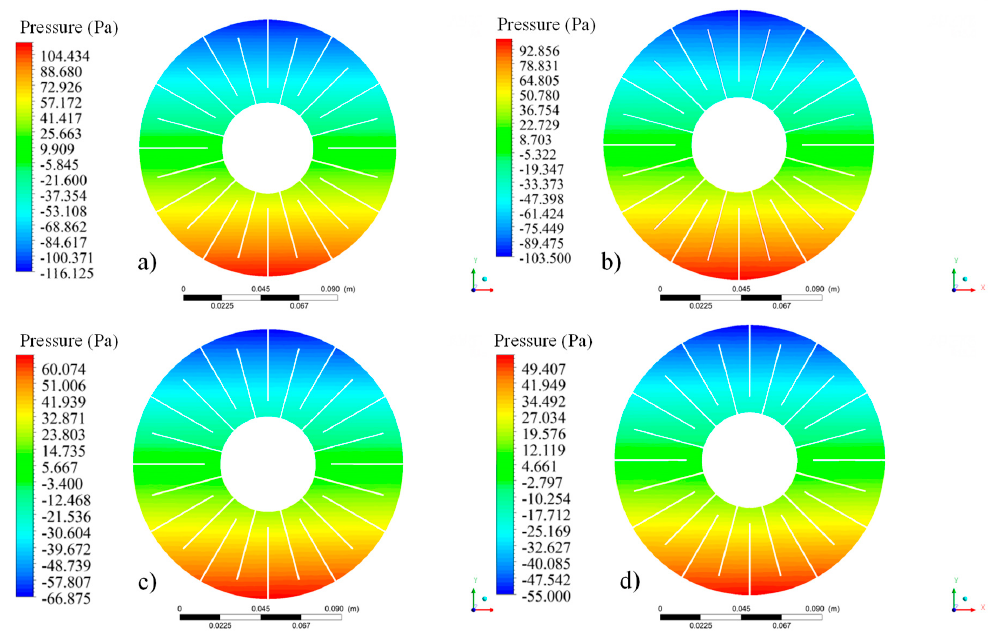
Figure 18. Pressure fields in the PCM domain for ( a ) 90% (t = 4942 s), ( b ) 80% (t = 5272 s), ( c ) 50% (t = 6522 s) and ( d ) 40% (t = 7112 s) of its volume in a liquid state. Energies 2023 , 16 , x FOR PEER REVIEW